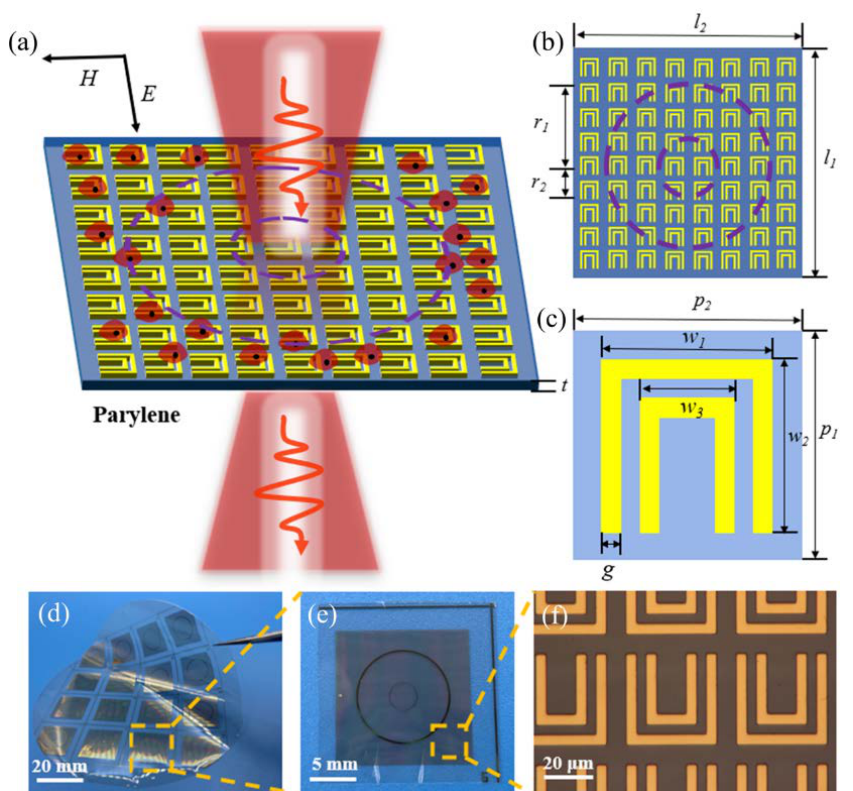
Figure 1. ( a ) Schematic illustration of the metamaterial biosensor: THz beams normally incident through the biosensor on which the MDA − MB − 231 cell was cultured; ( b ) the structure of the metamaterial biosensor. The geometrical parameters are l 1 = l 2 = 20 mm, r 1 = 5 mm, r 2 = 1.5 mm, and t = 15 µ m, respectively; ( c ) the structure of double U-shaped metamaterial. The geometrical parameters are p 1 = p 2 = 44 µm, w 1 = w 2 = 36 µm, w 3 = 2 = 0 µm, and g = 4 µm, respectively; ( d ) physical photograph of 4-inch biosensor; ( e ) physical photograph of 20 × 20 mm biosensor; ( f ) micrograph of the met-